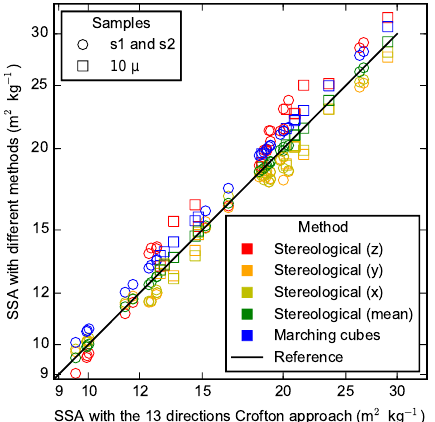
Figure 7. Comparison of the SSA obtained by different surface area calculation methods on all images binarised with the energy-based segmentation ( r = 1 voxel). The root mean square difference be- tween the SSA computed as the direction average of the stereolog- ical method and the SSA computed with the Crofton approach is 0.008m 2 kg − 1 . This difference is 1.13m 2 kg − 1 for the marching cubes approach. The black line represents the 1:1